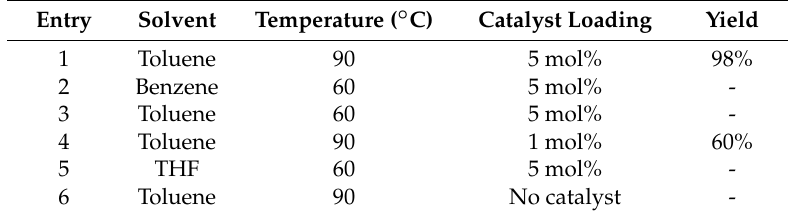
Table 1. Optimization of [Co II (TPP)] -catalyzed synthesis of azobenzene from azide 1 as a test substrate *.